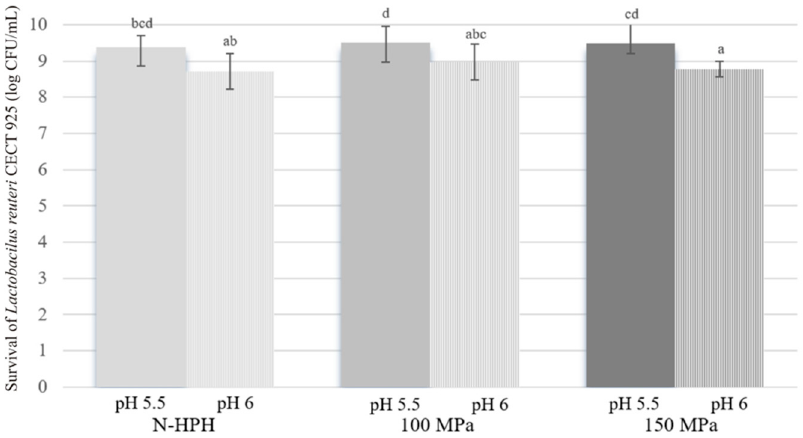
Figure 2. Impact of pH value and high homogenization pressures on survival of Lactobacillus reuteri CECT 925 in lulo juices after fermentation. Different letters denote significant differences ( p ≤ 0.05).